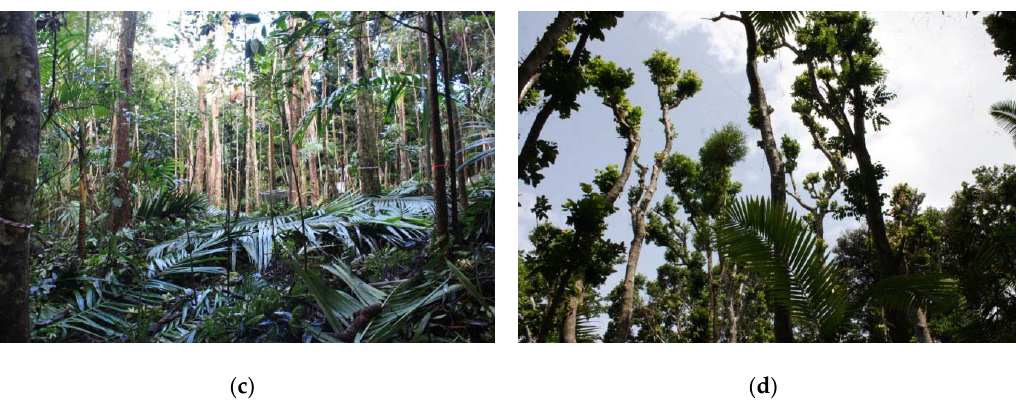
Figure 1. Photos of the canopy trimming and debris deposition (CTDD) plots before and after the CTDD treatment in the Luquillo Experimental Forest, Puerto Rico. ( a ) Dense forest canopy before the CTDD treatment; ( b ) Bare trunks after the CTDD treatment; ( c ) Thick litter deposition on the forest ground after the CTDD treatment; and ( d ) Recovery of trimmed forest after 12 weeks following the CTDD treatment. These photos were taken by Sarah Stankavich.